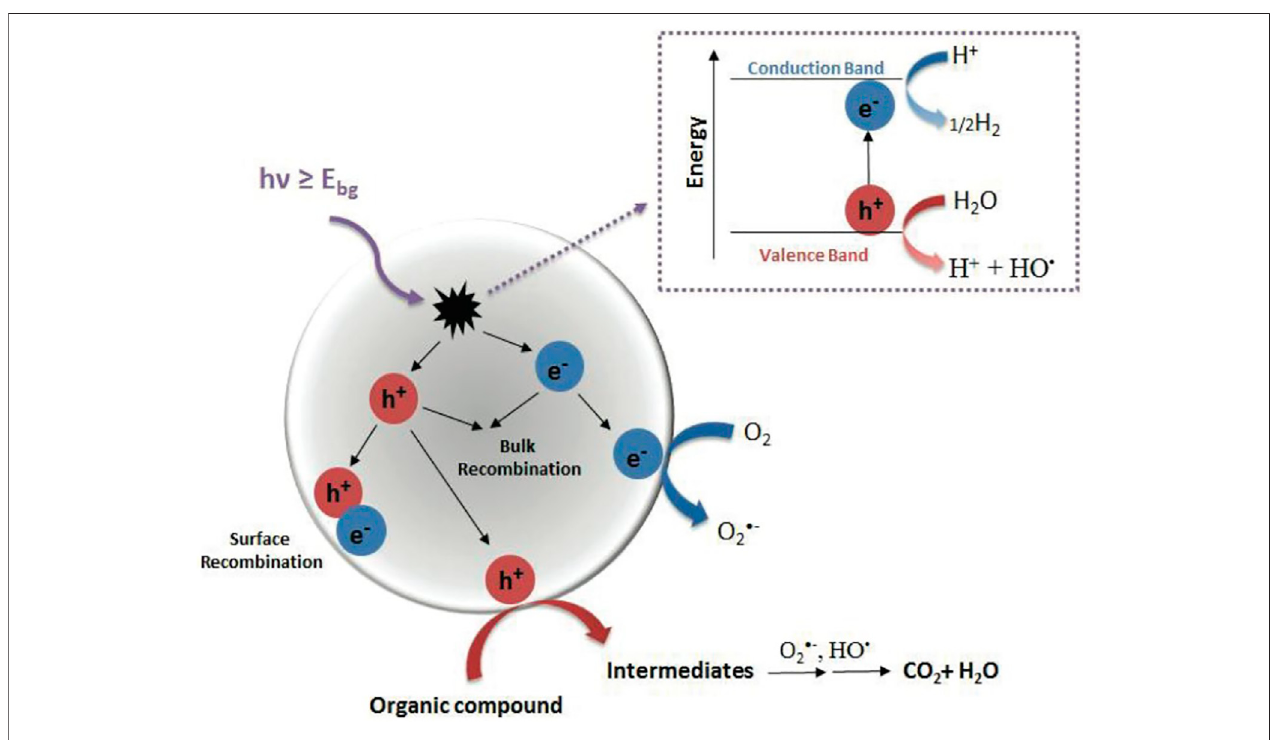
FIGURE 1 | Schematic map of the photocatalysis mechanism over an organic contaminant in water (Linsebigler et al., 1995).